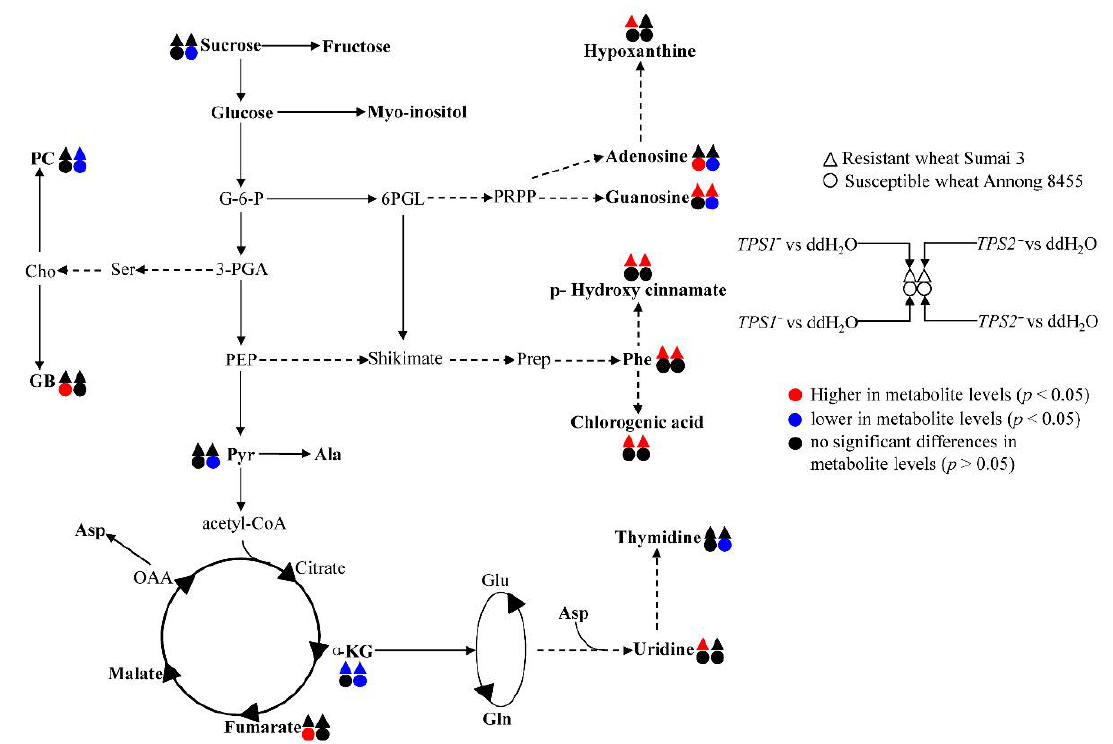
Figure 5. The metabolic responses of Sumai 3 and Annong 8455 to TPS − mutants and ddH 2 O inoculation. Red colored symbols indicate significant up-regulations of metabolites ( p < 0.05), whereas blue colored symbols represent downregulations of metabolites ( p < 0.05). G-6-P, glucose-6-phosphate; 3-PGA, 3-phosphate glycerate; Ser, serine; Cho, choline; PC, phosphocholine; GB, glycine betaine; OAA, oxaloacetic acid; Pyr, pyruvate; PEP, phosphoenolpyruvic acid; 6PGL, 6-phosphogluconate; PRPP, 5-phosphoribosyl diphosphate; Prep, prephenic acid.